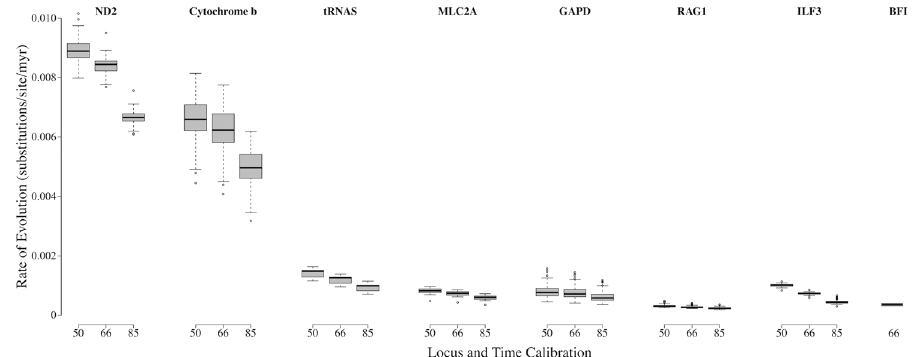
Fig 2. Box plot depicting the estimated rates of evolution of each study locus. Each box plot contains the estimates of evolutionary rate at each node and tip of the tree. The bottom and top of the box delimit the first and third quartiles, respectively, and whiskers extend to a maximum of 1.5 times the interquartile range. Asterisks indicate outlier